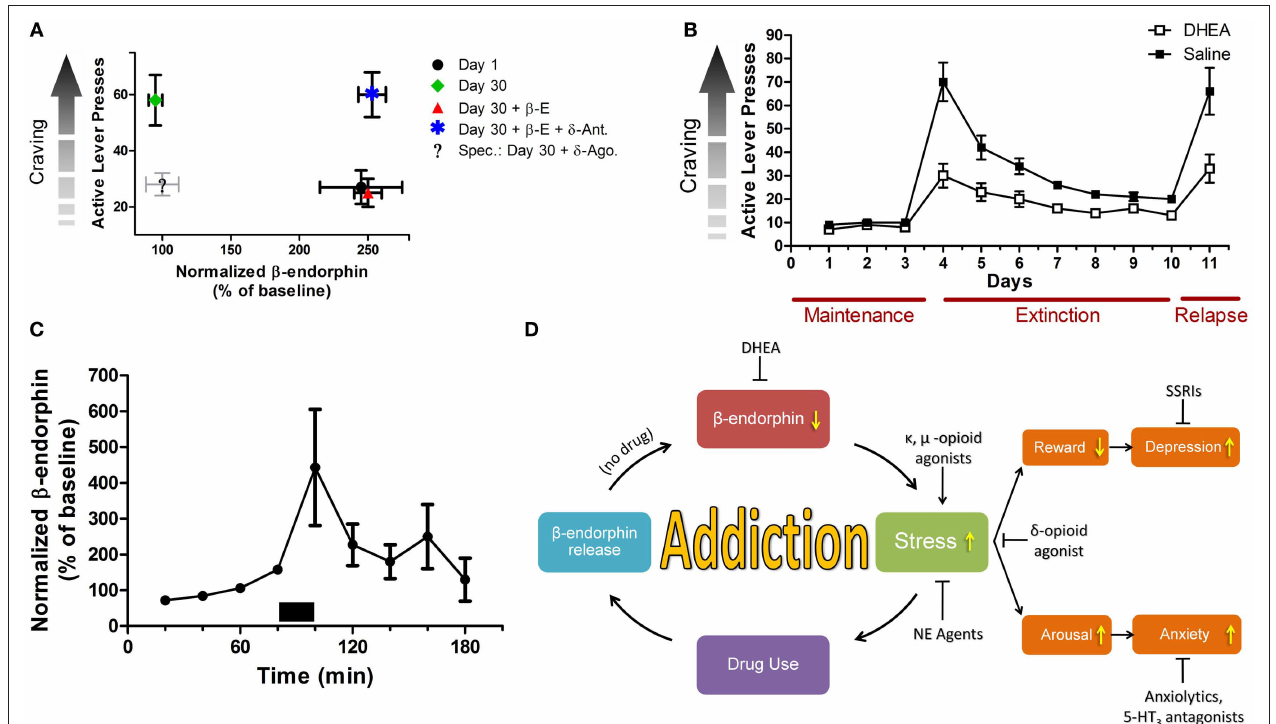
(B) Effect of DHEA treatment or saline on extinction of cocaine self- administration. Rats were trained to self administer cocaine (1.5 mg/kg/ infusion), after reaching stable maintenance, rats were either injected with DHEA or saline 90 min prior to placement in the operant chambers. After reaching abstinence, rats were reinstated with 10 mg/kg i.p. cocaine. DHEA significantly facilitates withdrawal and attenuates drug-induced relapse. (C) DHEA and β -endorphin are linked together. Using the reverse microdialysis technique, DHEA-sulfate (30 nM, marked by a bar) was applied into the n. accumbens, and β -endorphin levels in dialysates were measured. Perfusion of DHEA-sulfate causes a significant in situ transient increase in β